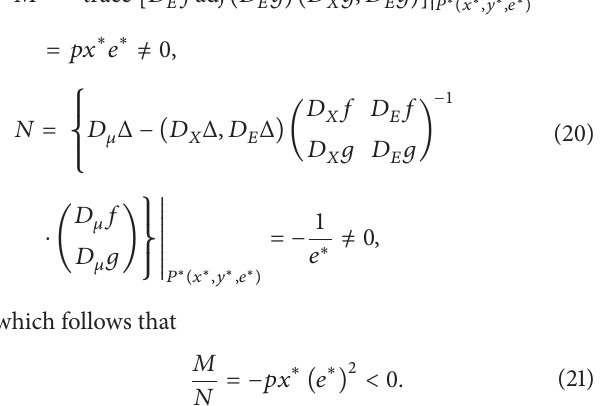
Table 1: Signs of real parts of eigenvalues of system (13) at 𝑃 ∗ . Parameter